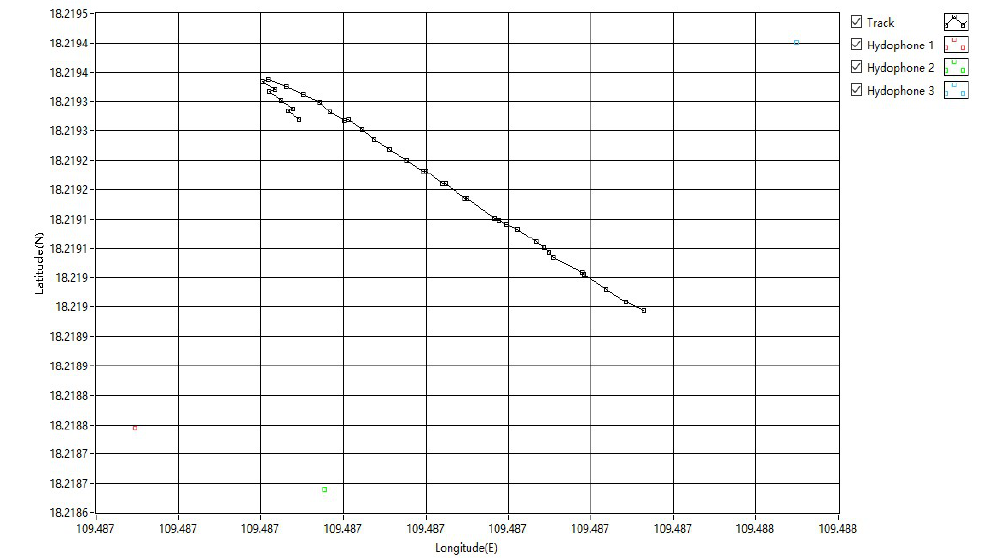
Figure 18. Signal trajectory.